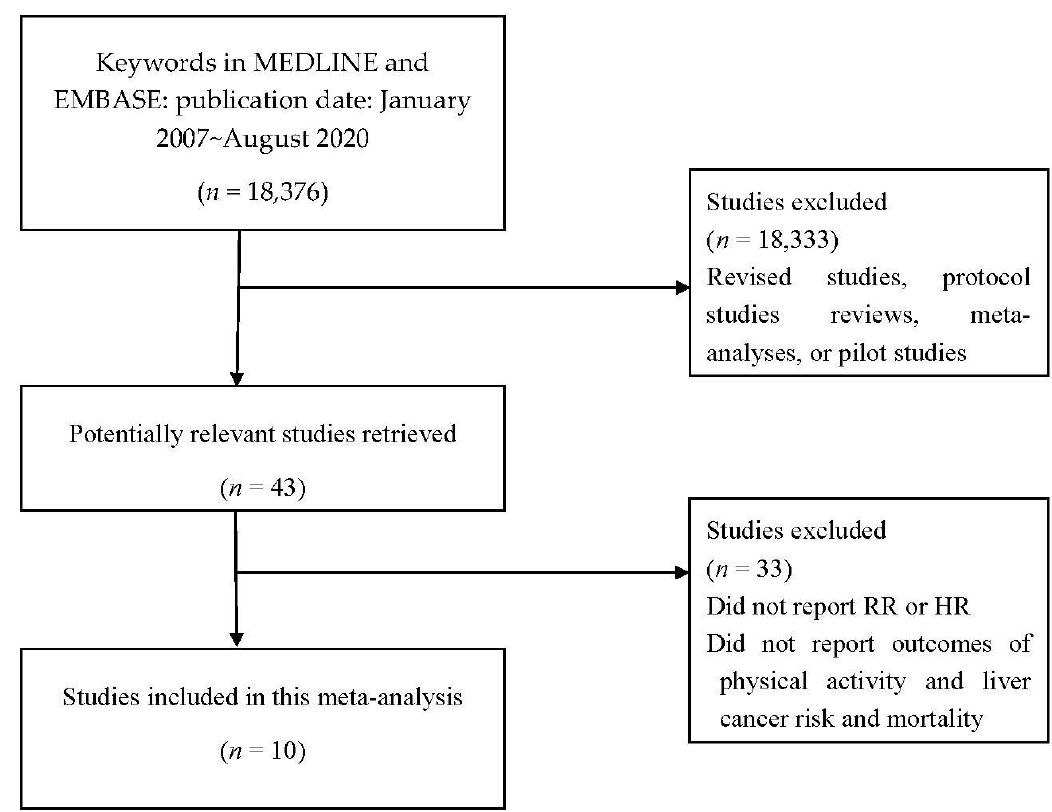
Figure 1. Selection process for the systematic review and meta-analysis.